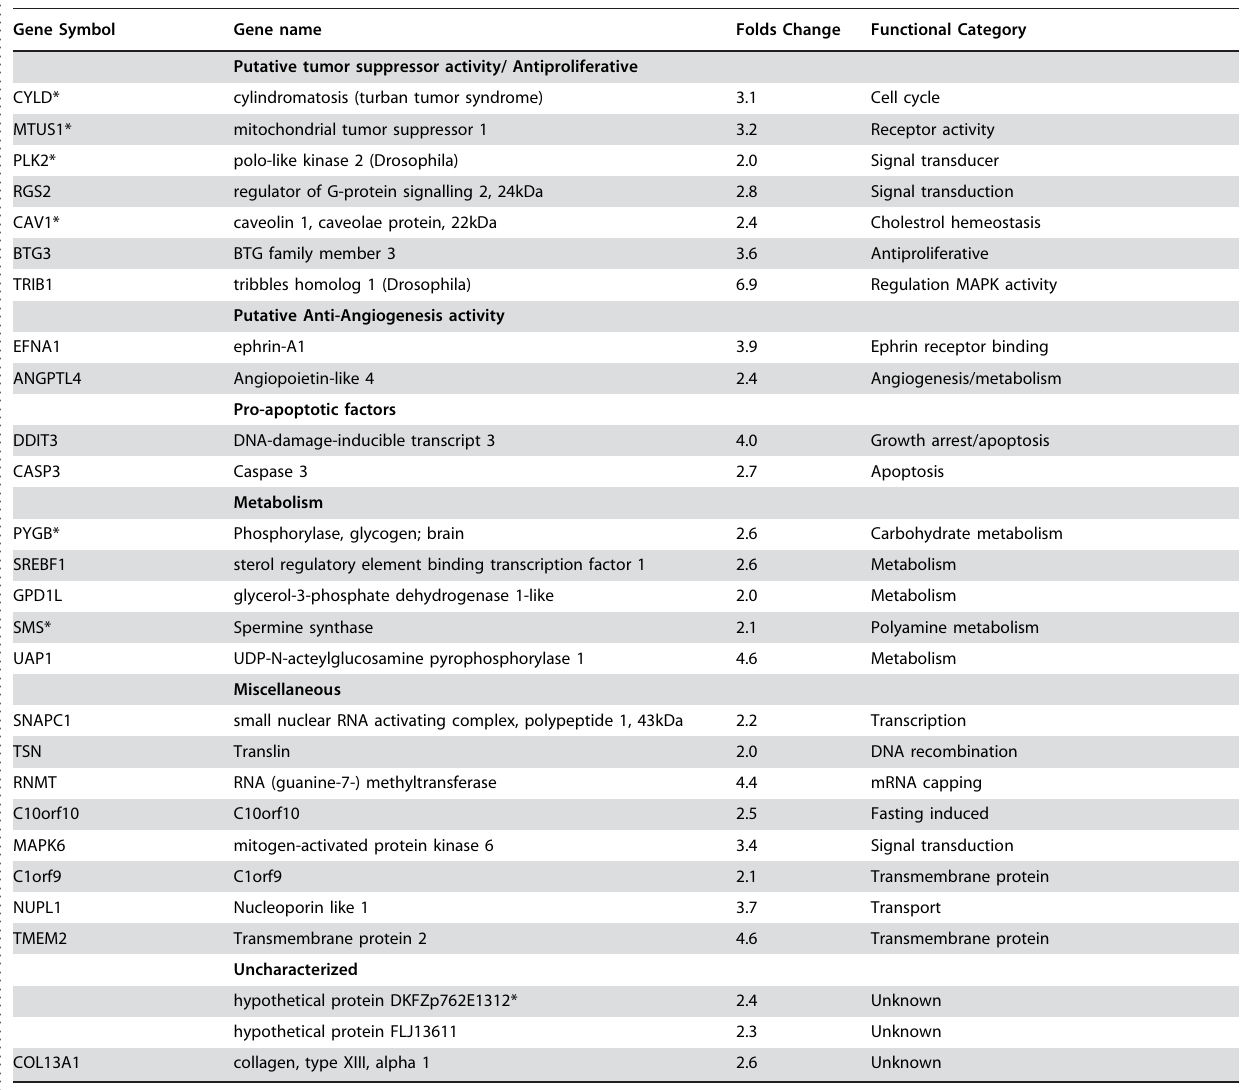
Table 2. Genes induced by at least two-folds by H19 knockdown under hypoxic stress. .. ... .... ... ... .... ... ... .... ... ... .... ... ... .... ... ... .... ... ... .... ... ... .... ... ... .... ... ... .... ... ... .... ... ... .... ... ... .... ... ... .... ... ... . Gene Symbol